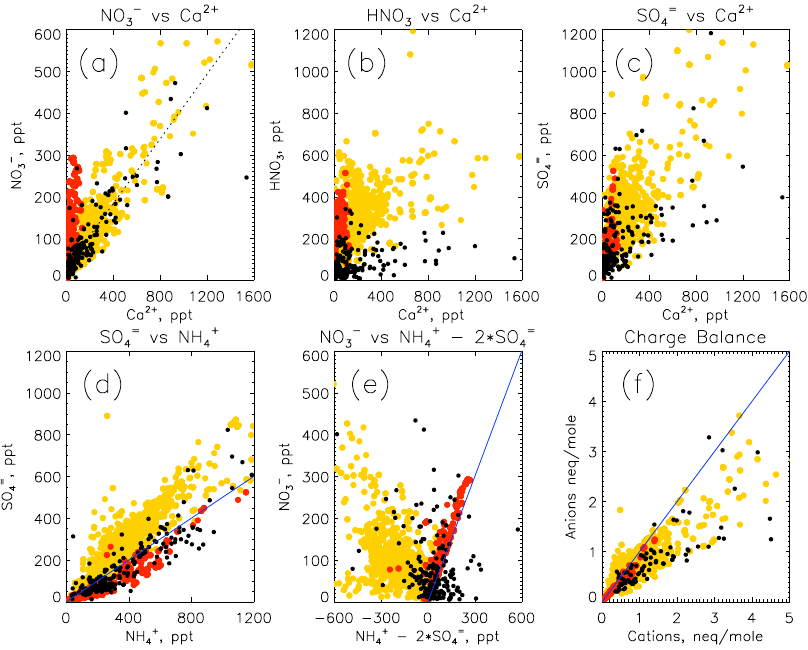
Fig. 4b. Same as Fig. 4a, but for the simulation including acid uptake on dust. The same colors mark the same points in both simulations. Black line in panel (a) is linear best fit to the model (yellow)